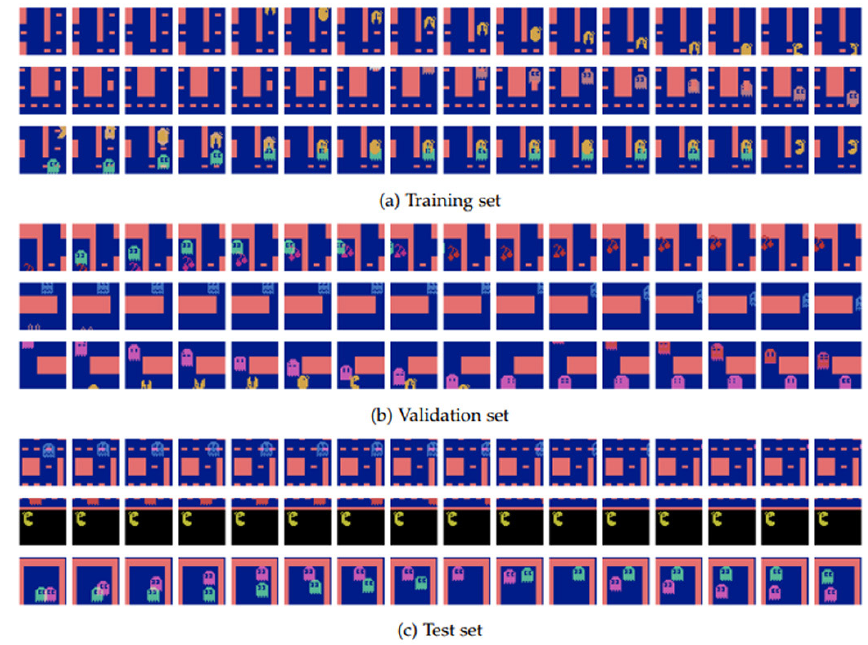
Fig. 6. Example sequences from different splits of the used MsPacman